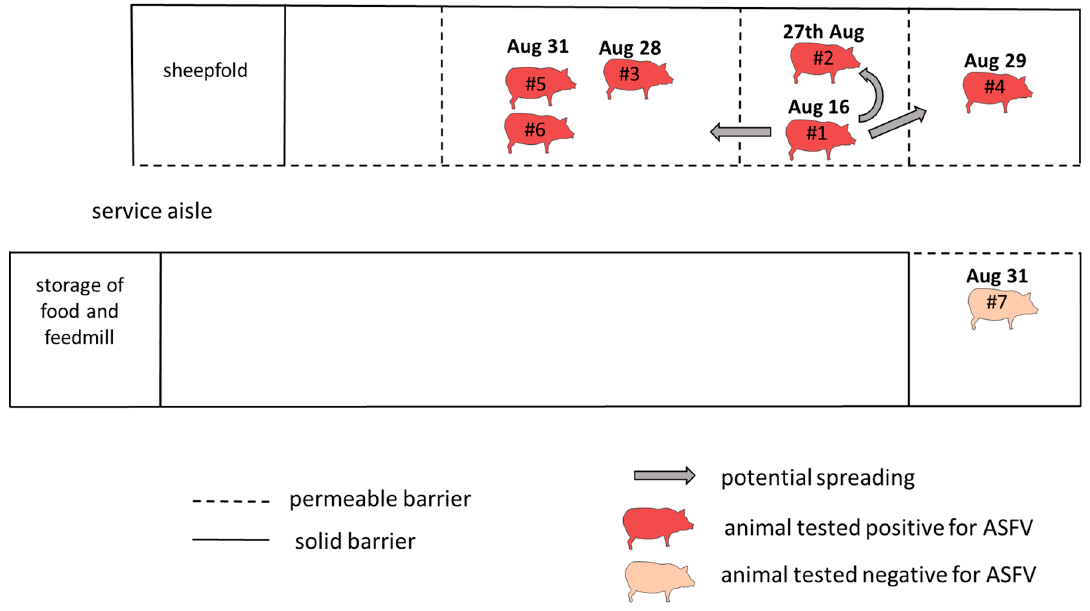
Figure 2. Potential spreading scenario.